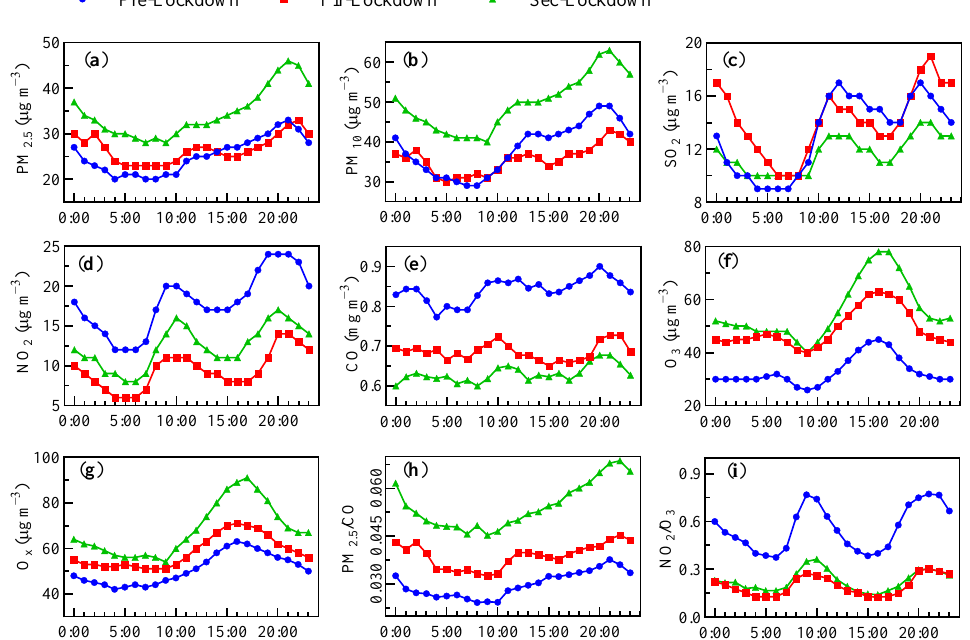
Figure 4. Hourly mean values of air pollutants and its ratios in a day during the Pre-Lockdown, Fir-Lockdown, and Sec-Lockdown stage. ( a ) PM 2.5 , ( b )PM 10 , ( c ) SO 2 , ( d ) NO 2 , ( e ) CO, ( f ) O 3 , ( g ) O x , ( h ) PM 2.5 /CO, ( i ) NO 2 /O 3 . The hourly mean concentration of PM 2.5 during the Fir-Lockdown period was com-